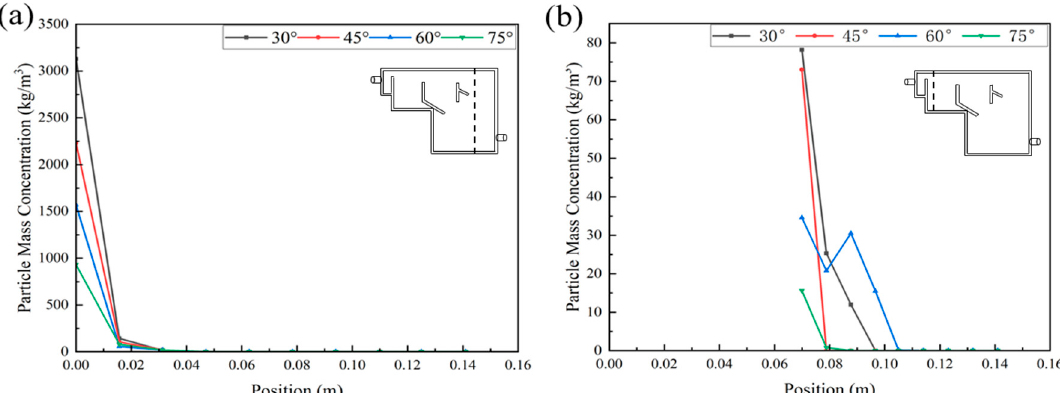
Figure 8. The change in particle concentration in the vertical direction of the pre-sedimentation zone ( a ) and secondary settling zone ( b ) of the reactor with different baffle angles. ( a ) and secondary settling zone ( b ) of the reactor with different baffle